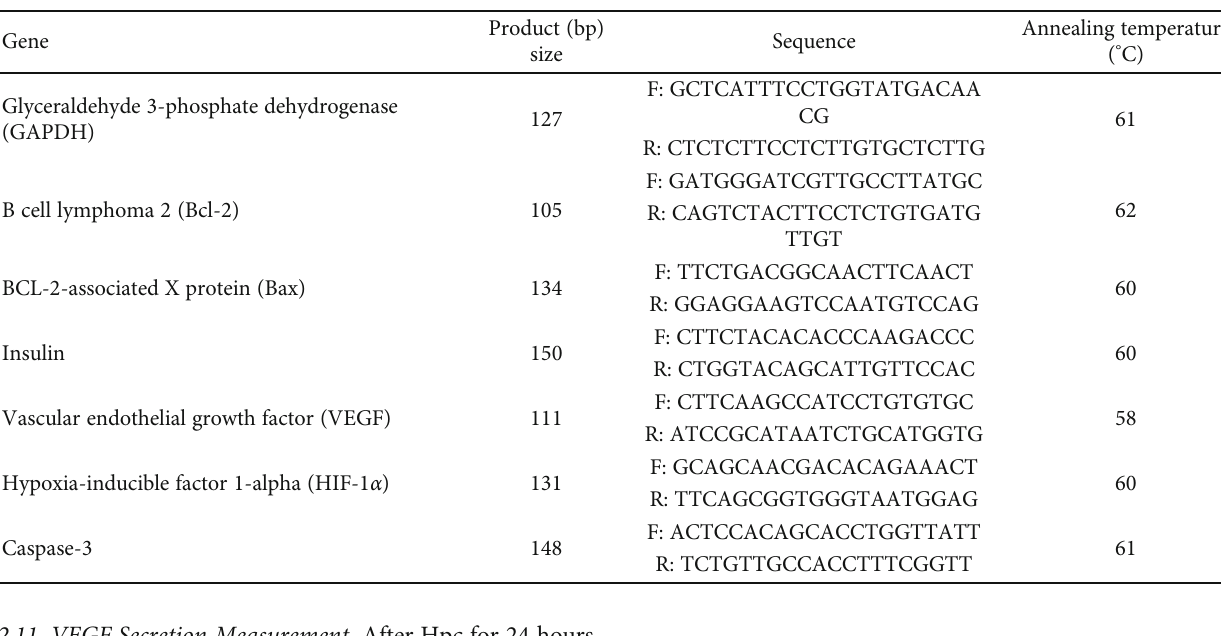
Table 1: The designed primers.